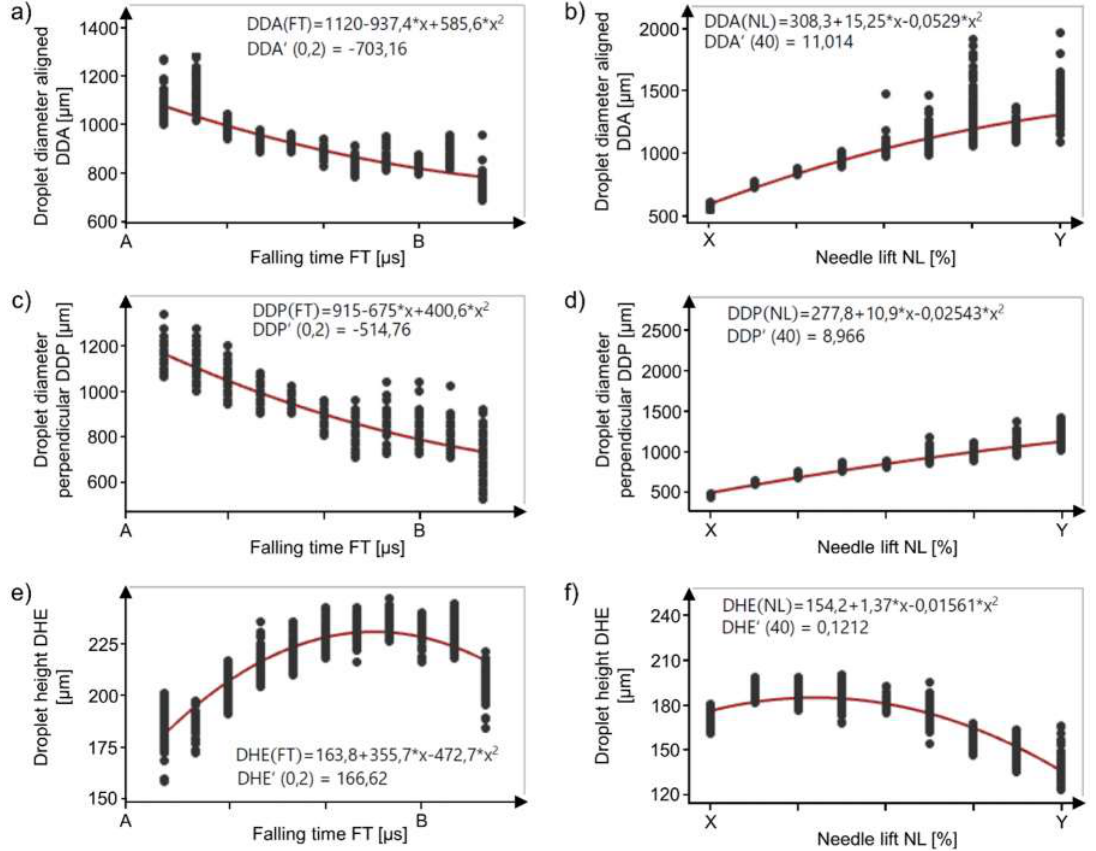
Figure 6. Regression analysis of the preliminary tests of falling time and needle lift determining ( a , b ) droplet diameter aligned DDA, ( c , d ) droplet diameter perpendicular DDP and ( e , f ) droplet height DHE.